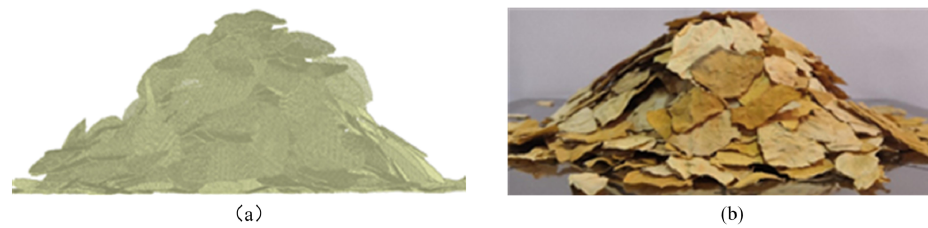
Figure 6. Comparison between simulation and physical tests of the stacking angle of tobacco strips. ( a ) Simulation tests; ( b ) Physical